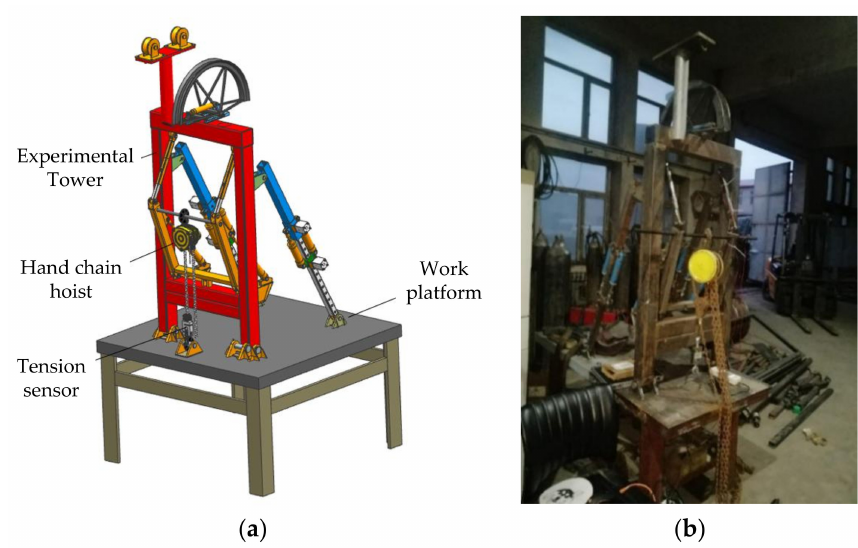
Figure 21. Schematic diagram of scale model experimental system ( a ) and physical device ( b ). Table 5. Experimental sea conditions.